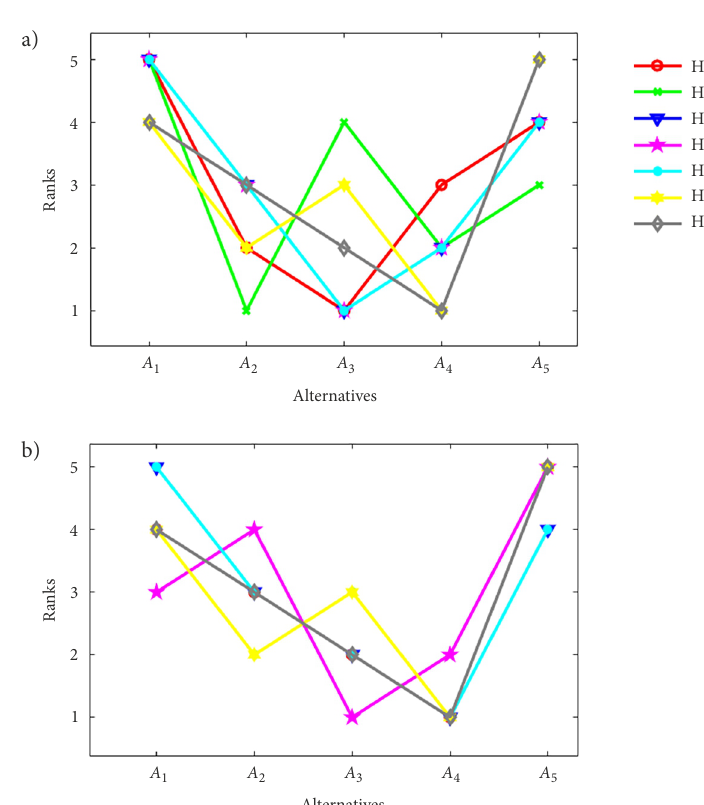
Figure 4. Ranking schematic map under different weight distribution: a – sensitive analyses of q-R-TOPSIS; b – sensitive analyses of